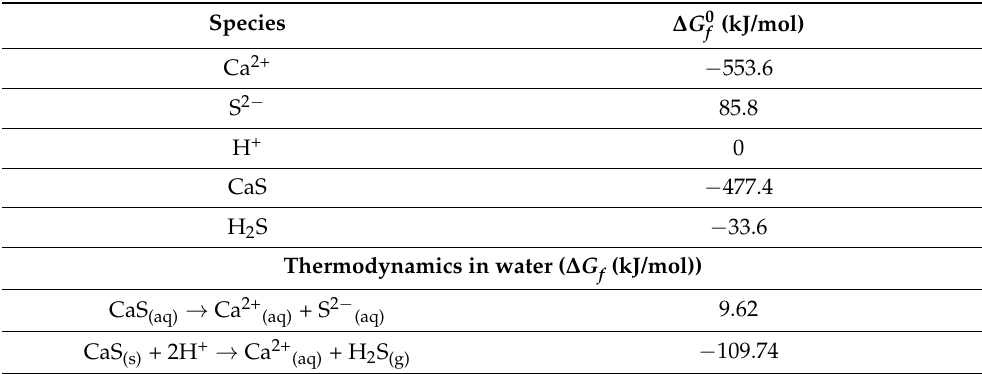
Table 4. The standard Gibbs free energy ( ∆ G 0 and sulfide in an aqueous